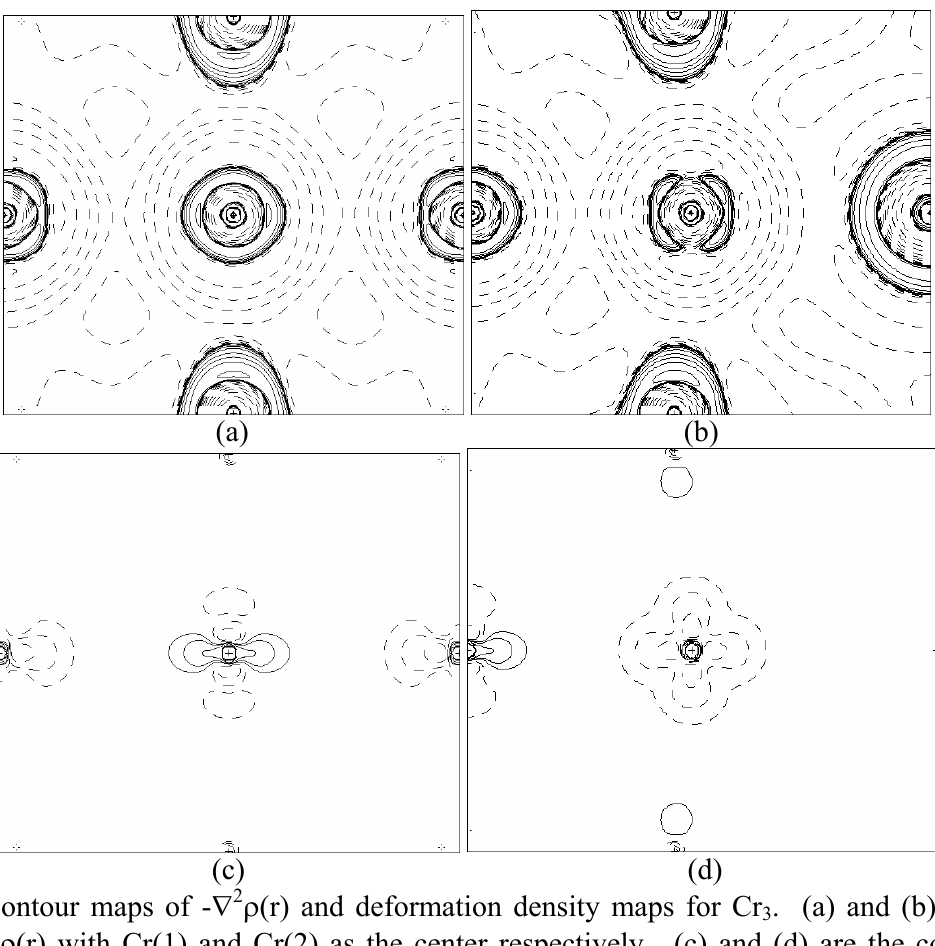
Figure 4 Contour maps of - ∇ 2 ρ (r) and deformation density maps for Cr maps of - ∇ 2 ρ (r) with Cr(1) and Cr(2) as the center respectively. (c) and (d) are the corresponding deformation density maps. The planes presented in the figures are through the Cr chain and the Cr-N bond of the center Cr ion. The contours are drawn in the order 2x10 n , 4x10 n , 8x10 n with n beginning at –2 and increasing in step of 1. This geometric progression also defined the contour values of - ∇ 2 ρ (r), positive values being denoted by solid lines and negative values by dashed lines. In the deformation density maps, the solid lines are charge concentration, and the broken lines are charge